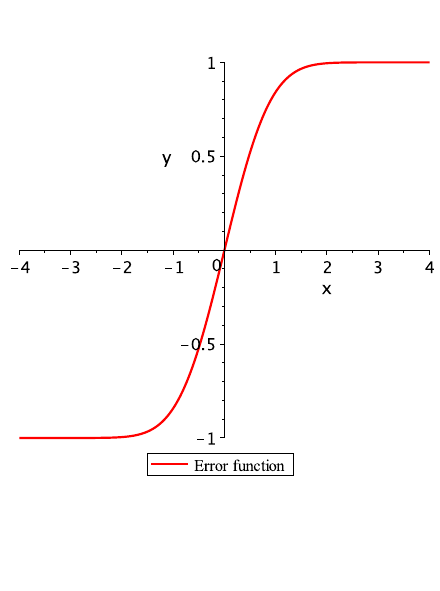
Figure 2: Error function (3)